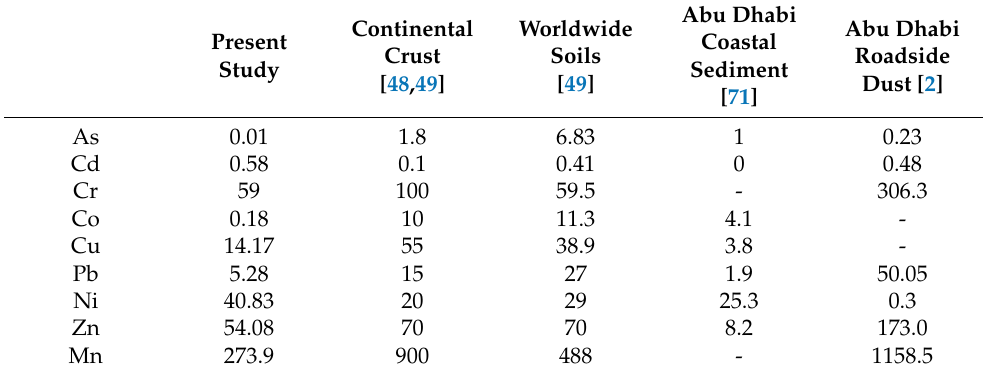
Table 3. Heavy metals concentration (mg/kg) in this study compared to their averages in the upper continental crust, worldwide soils, and coastal sediments and roadside dust in Abu Dhabi. Continental Worldwide Present Crust Study [48,49]